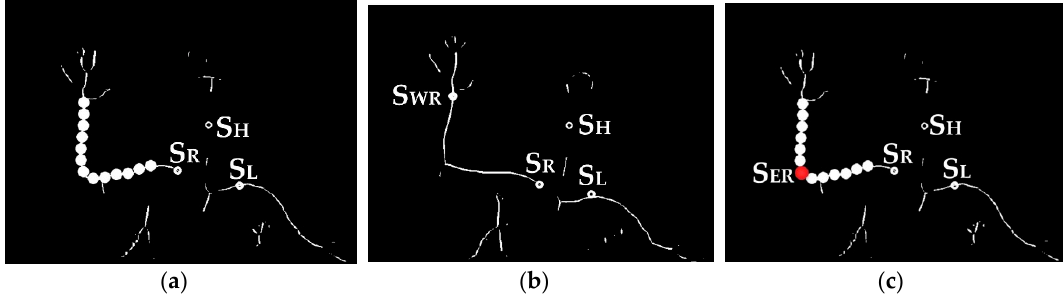
Figure 13. The established skeleton points of the wrist and elbow: ( a ) All the points we found constitute arm skeleton points. ( b ) We set the end points at the wrist skeleton points. ( c ) We set the skeleton point of the elbow halfway between the whole arm skeleton points.